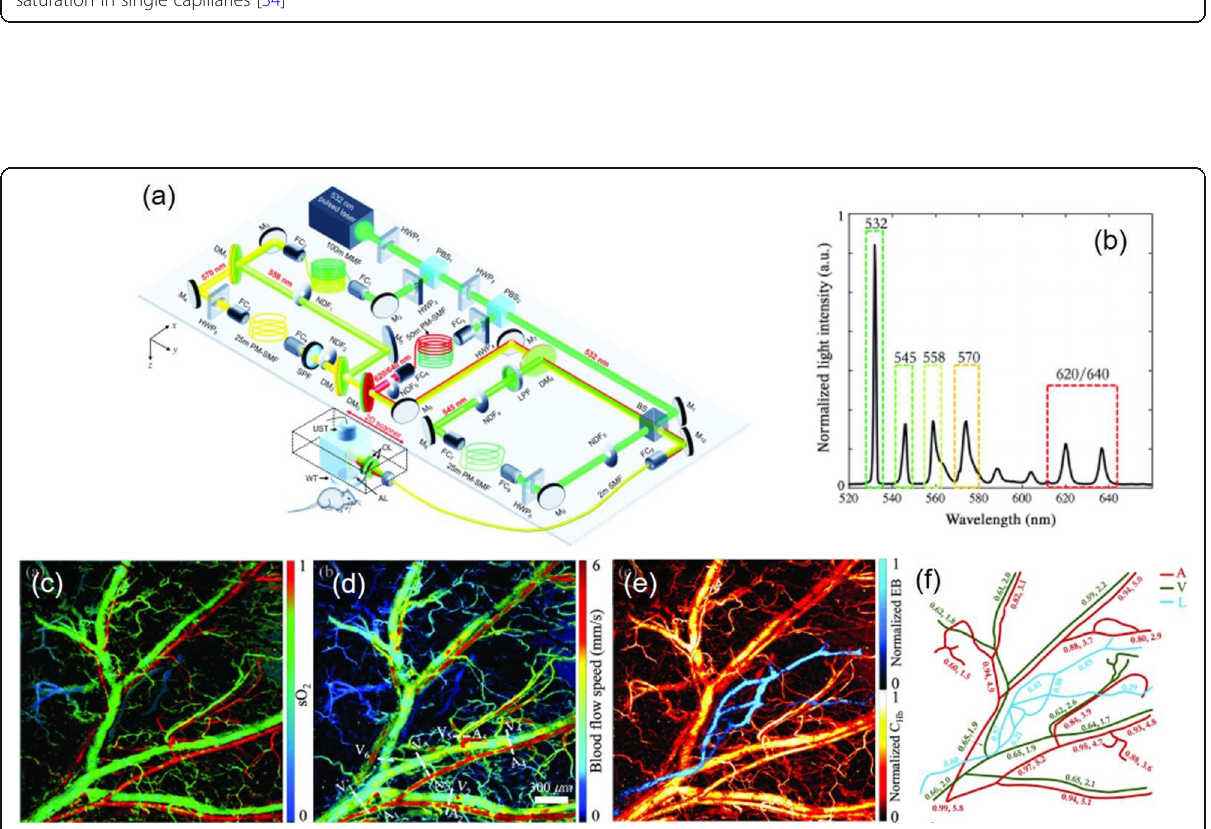
Fig. 6 PAM with a five-wavelength SRS fiber laser source. ( a ): Schematic of the five-wavelength fiber laser and PAM; ( b ): Laser output spectrum; ( c ): Imaging result of oxygen saturation; ( d ): Blood flow speed determined using the dual-pulse method; ( e ): PAM imaging of the blood and lymphatic vessels; and ( f ): Variation of the oxygen saturation, blood flow speed, and relative lymphatic concentration from the root to the tip of a mouse ear. A: arteries; V: veins; L: lymphatic vessels